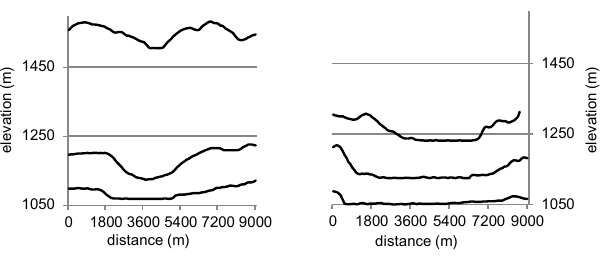
Fig. 3 Transverse valley profiles of the Cubango (left) and Cuito (right) for the headwaters (top), middle course (centre) and lower course (bottom) of both rivers. Pixel resolution of DEM: 90 m. Location, see Fig.